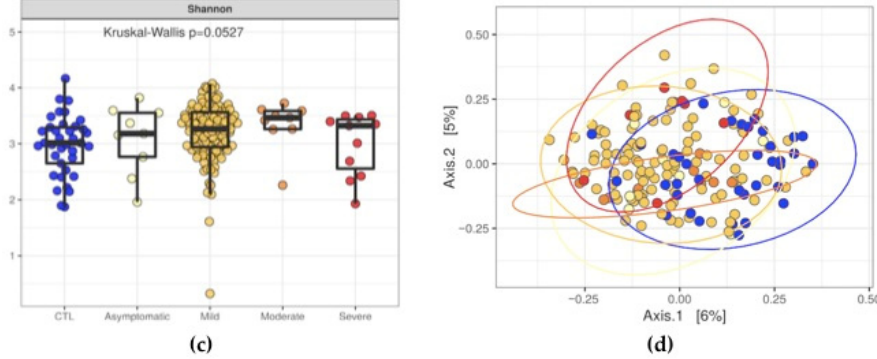
Figure 1. Diversity analysis of the intestinal microbiota from post-COVID-19 patients (COV) and control subjects (CTL). ( a , c ) Shannon indices showing the evenness of the intestinal microbiota, and ( b , d ) Principal Coordinate Analysis (PCoA) plots showing the differences in microbiota diversity between post-COVID-19 patients and control subjects.